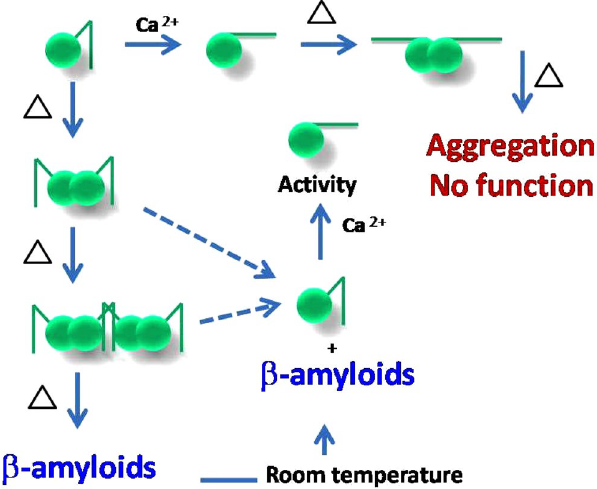
Figure 8. This schematic representation depicts the monomer-dimer/tetramer and oligomers of 28–161 as a function of temperature and Ca 2 + ion shown here summarizes the results observed in this